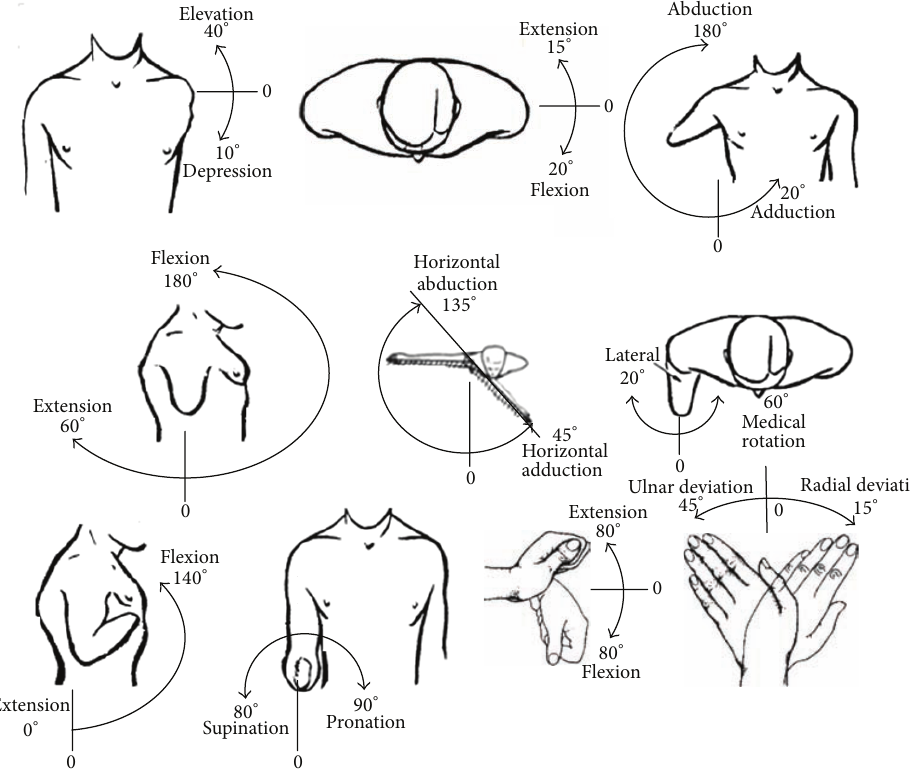
Figure 11: Different motions of human